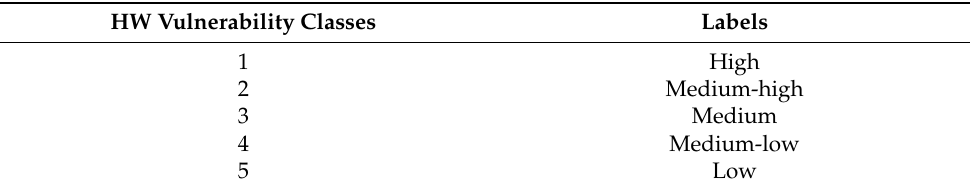
Table 2. HW Vulnerability partitioning.